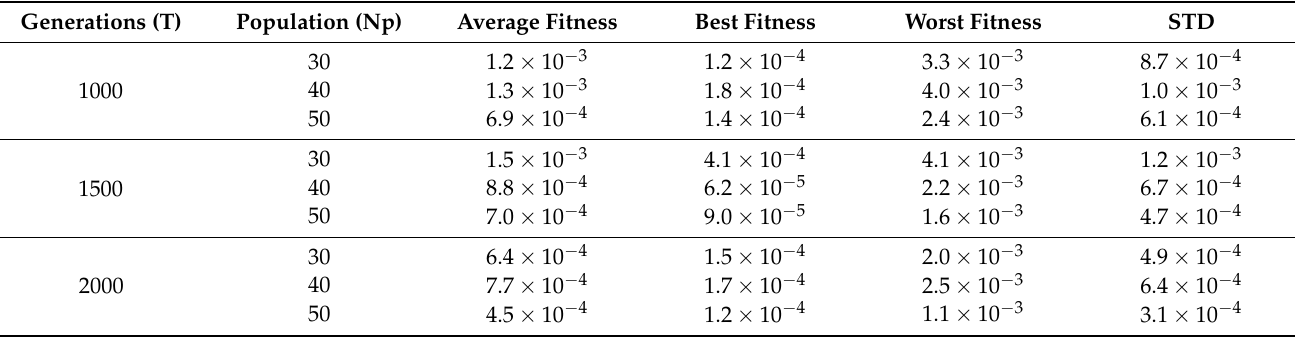
Table 2. AO parameter analysis for case 1.